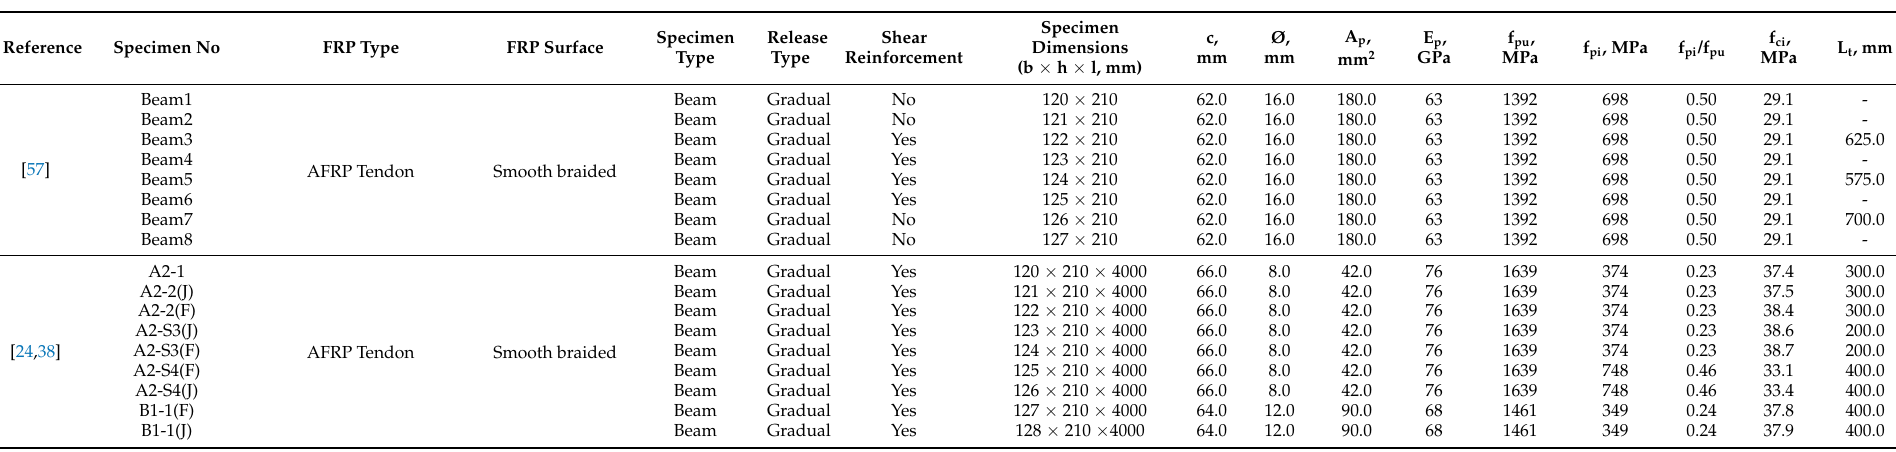
Table 4. Geometrical, mechanical properties of the material and transfer lengths of specimens with pretensioned AFRP